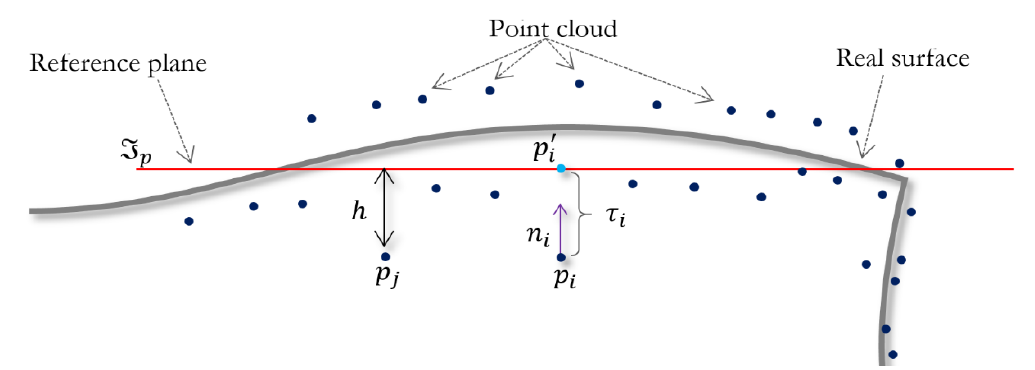
Figure 1. The point p i is projected onto the reference plane. (cid:61) p is a linear approximation to the surface.